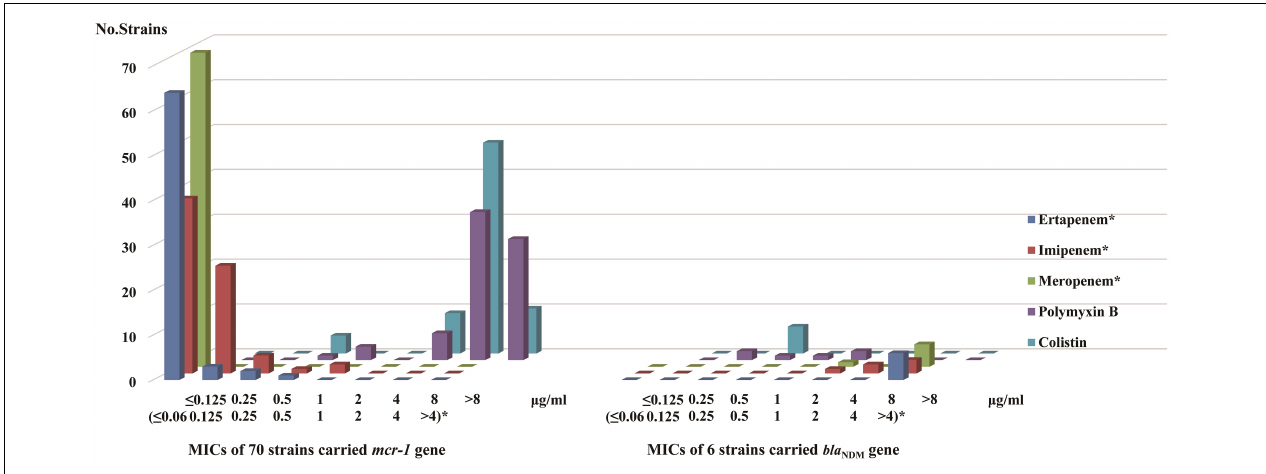
FIGURE 3 | MICs distribution of carbapenem antibiotics and polymyxins in mcr-1 and bla NDM gene carriers MIC values ( ≤ 0.06 ∼ > 4 µ g/ml)* in regard to ertapenem, imipenem, and meropenem. MIC values ≤ 0.125 ∼ > 8 µ g/ml in regard to polymyxin B and